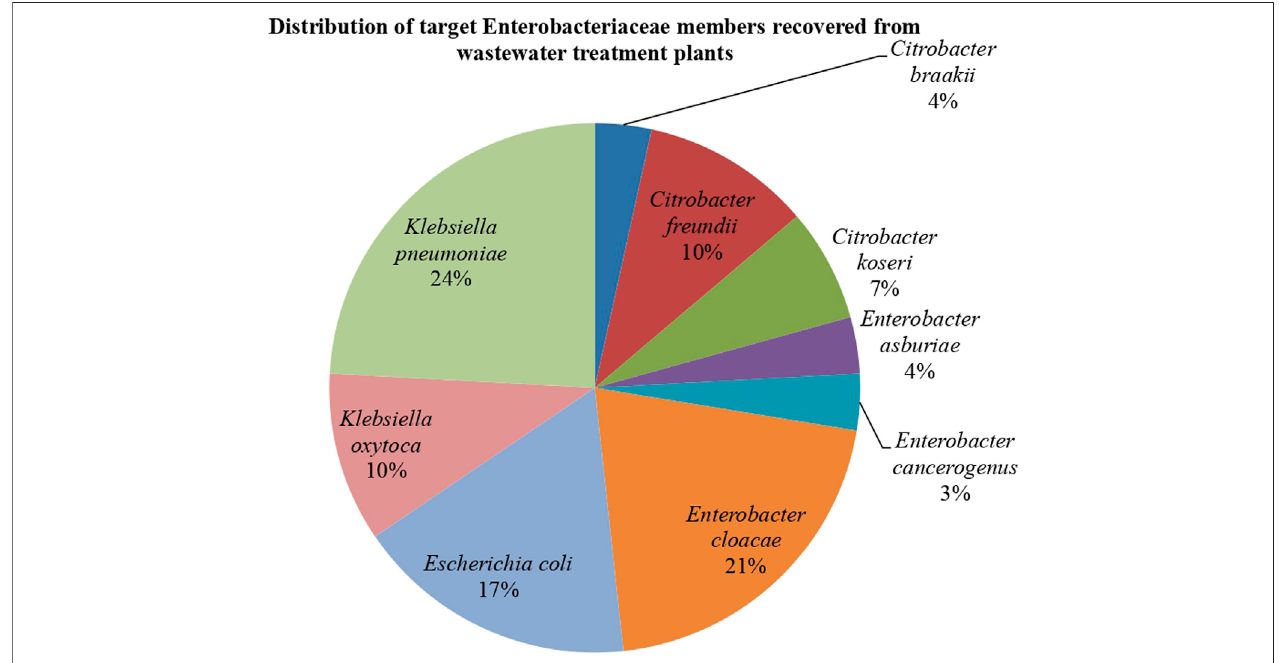
FIGURE 2 | The distribution of the targeted Enterobacteriaceae ’ members ( n (cid:1) 29) recovered from wastewater treatment plants.